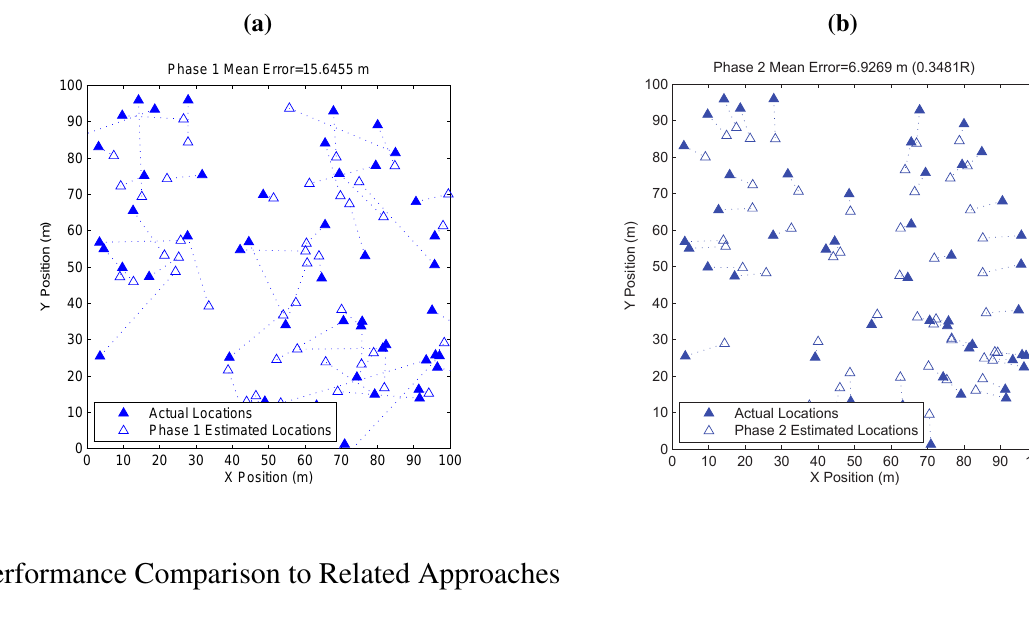
Figure 8. The estimated locations from two phases comparing to the true locations. (a) phase 1 estimated locations; (b) phase 2 estimated